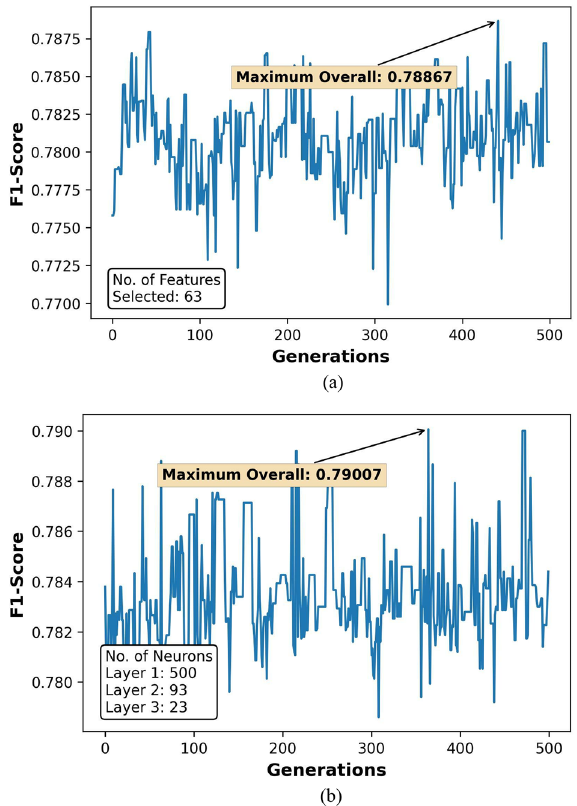
Figure 7. F1-Score for classifier ANN model during ( a ) feature selection and ( b ) hyperparameter